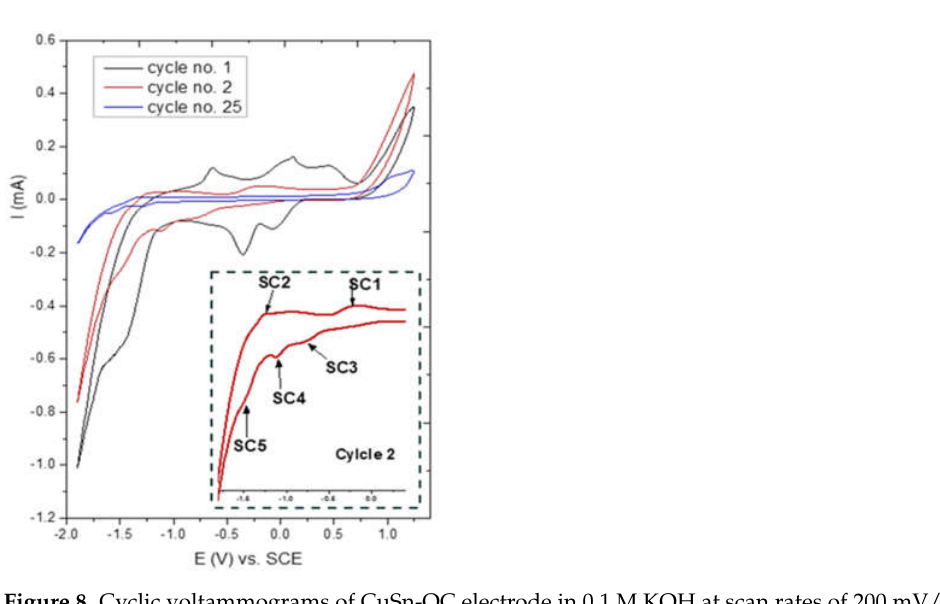
Figure 8. Cyclic voltammograms of CuSn-OC electrode in 0.1 M KOH at scan rates of 200 mV/s.